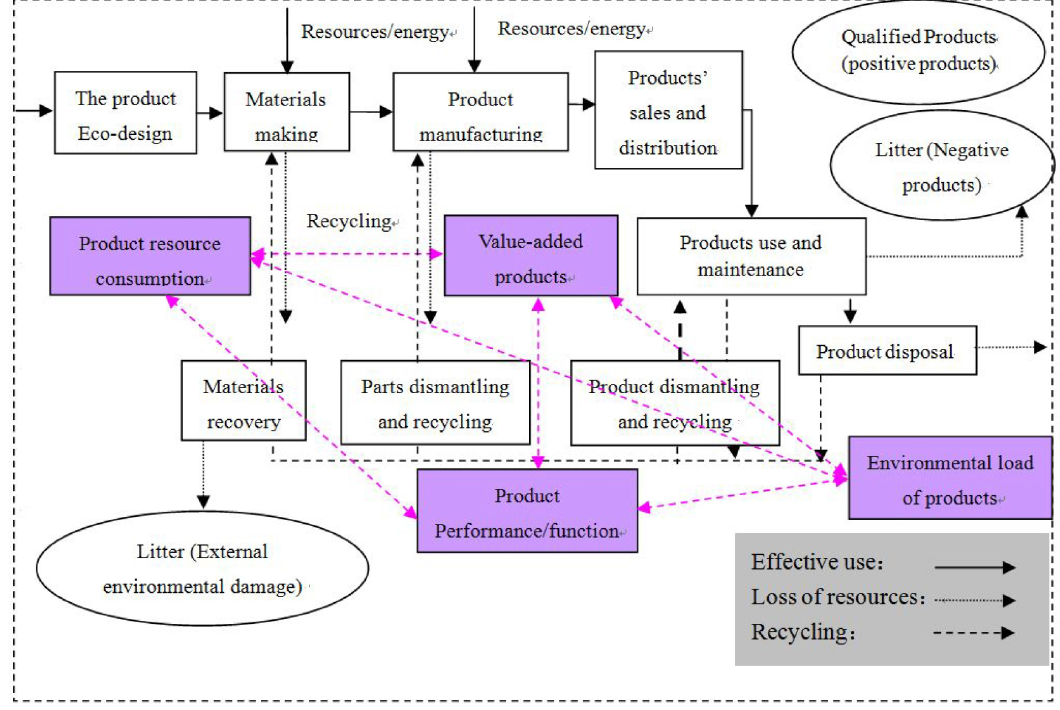
Figure 4. Cost accounting and analysis framework of resources flow based on